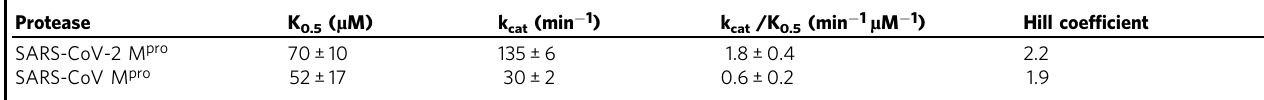
Table 1 Catalytic parameters of SARS-CoV M pro and SARS-CoV-2 M pro .